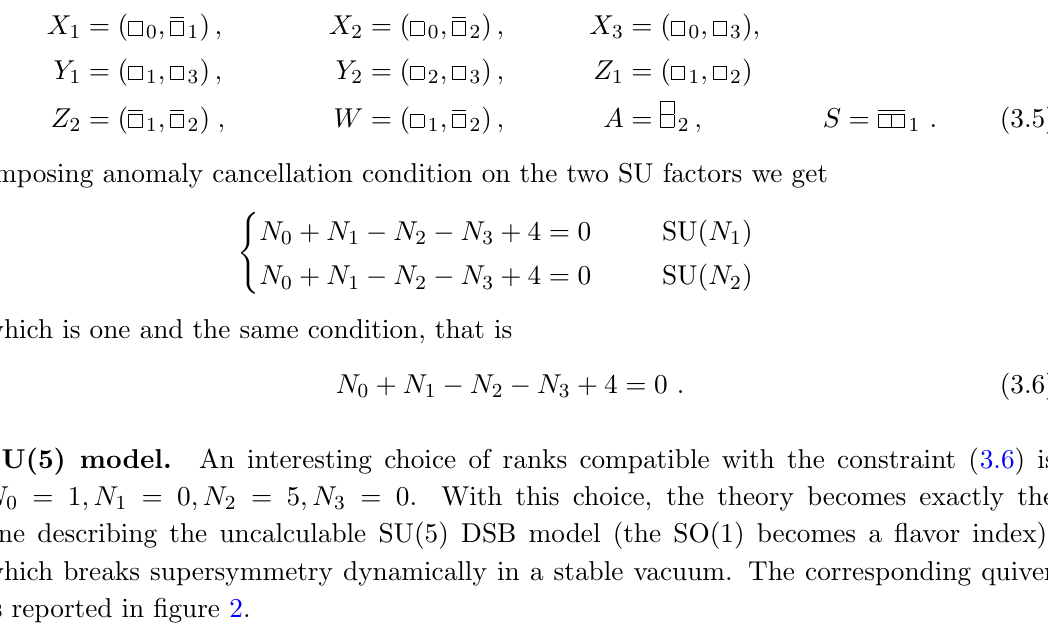
Figure 2 . The quiver of the SU(5) model at the C 3 = Z the de(cid:12)nitions in eq. (3.5). The asterisk refers to the anti-symmetric